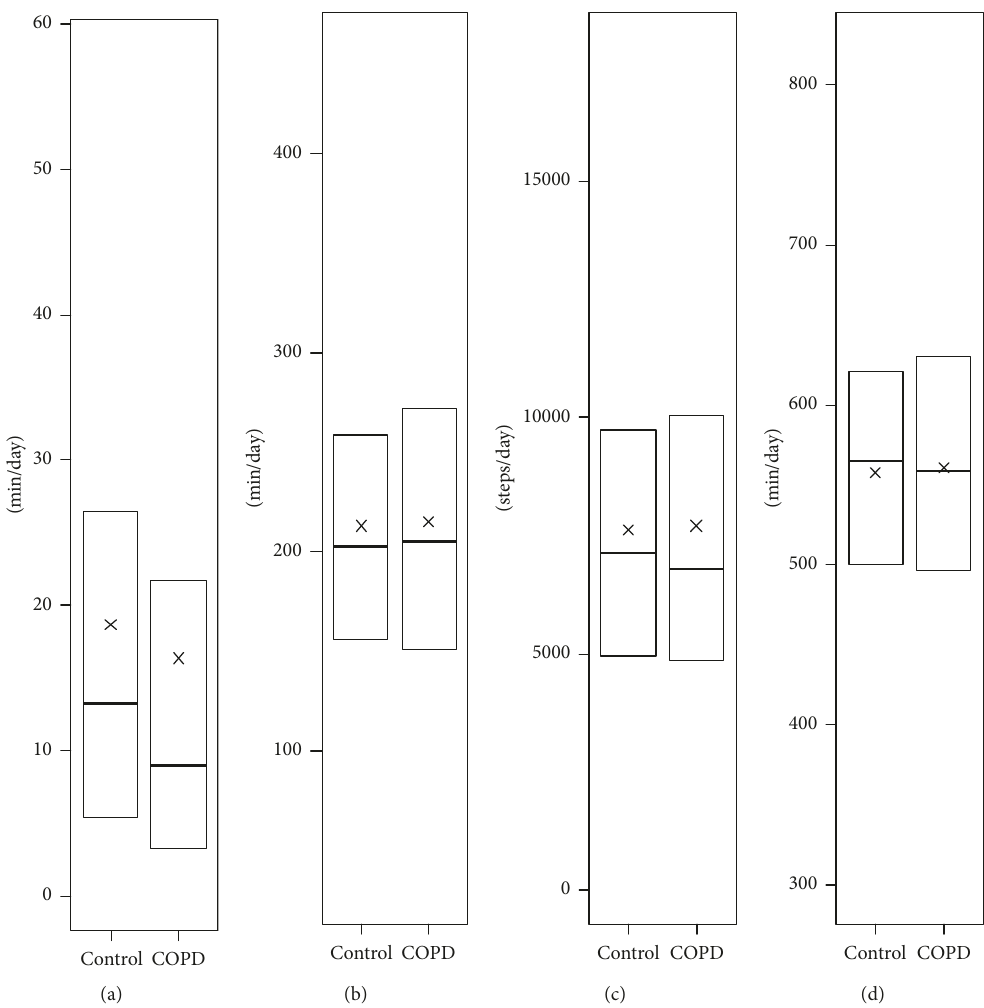
Figure 1: Daily physical activity and sedentary in participants with and without COPD. (a) Moderate and vigorous physical activity (MVPA). (b) Light physical activity (LPA). (c) Steps. (d) Sedentary. x � mean. The whiskers are voluntary missing because Statistics Canada does not allow figures with individual data representation. Table 3: Weighted ANCOVA table for COPD severity and MVPA controlling for age, body mass index, sex, accelerometer wearing